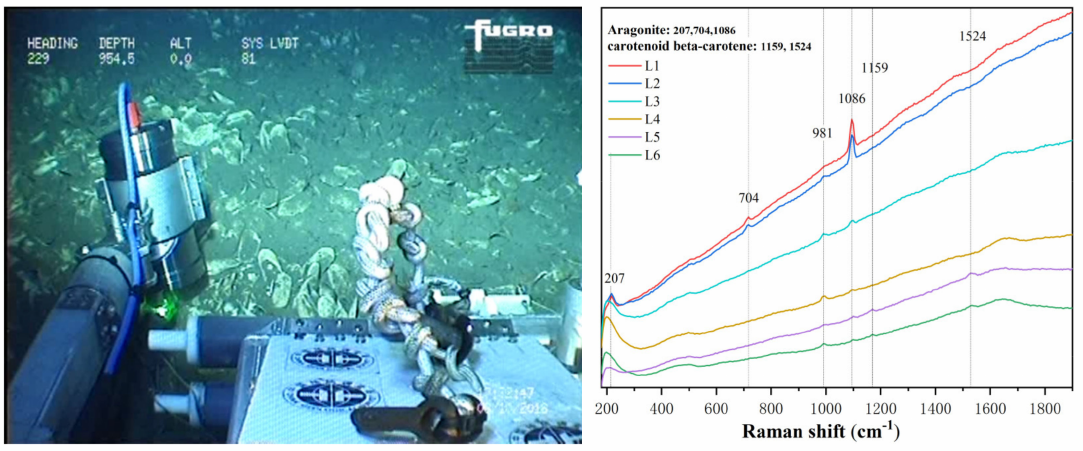
Figure 9. The image showing the easy-to-operate system is detecting the clamshell in the abandoned cold seep field ( left ) and the obtained spectra from the clamshell taken in different locations ( right